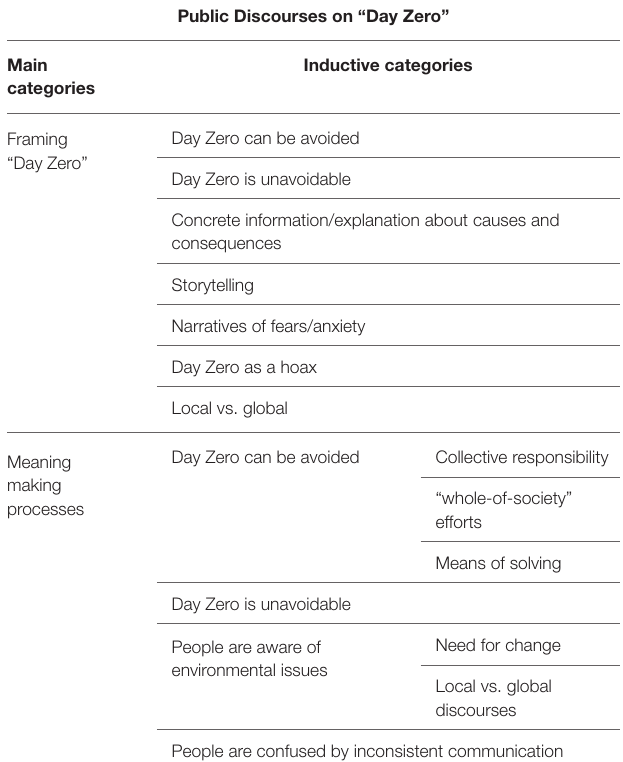
TABLE 1 | Public discourses on “Day Zero” —inductive category development. TABLE 2 | Interpretative patterns of “Day Zero.”